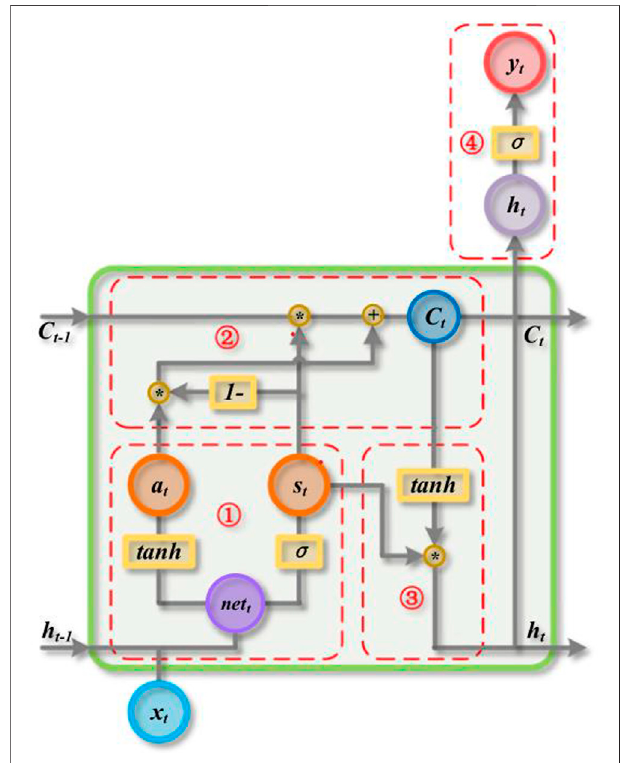
FIGURE 1 | Schematic of the SWLSTM network